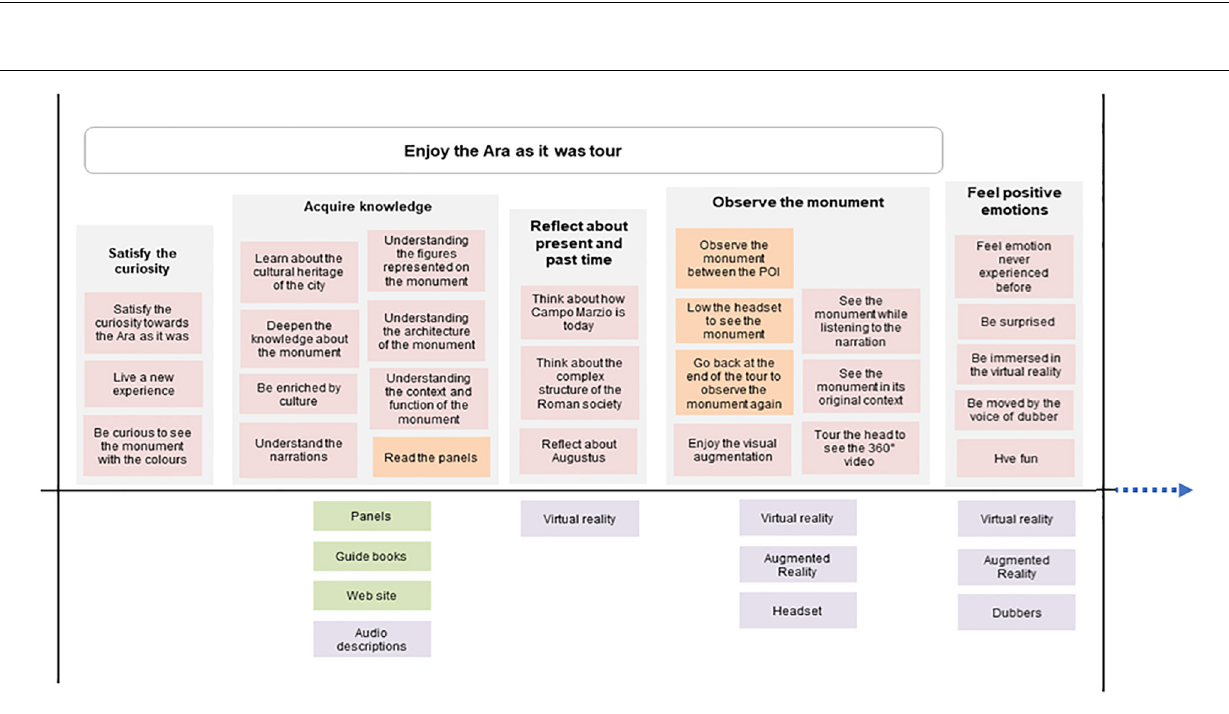
FIGURE 2 | Second portion of the Activity Diagram representing: in the upper part, the core activities of the visit tour (satisfy the curiosity, acquire knowledge, reflect about present and past time, observe the monument, and feel positive emotions); in the bottom part, the features of the Ara as it was tour and the museum artifact ecology that the visitors used to perform the above